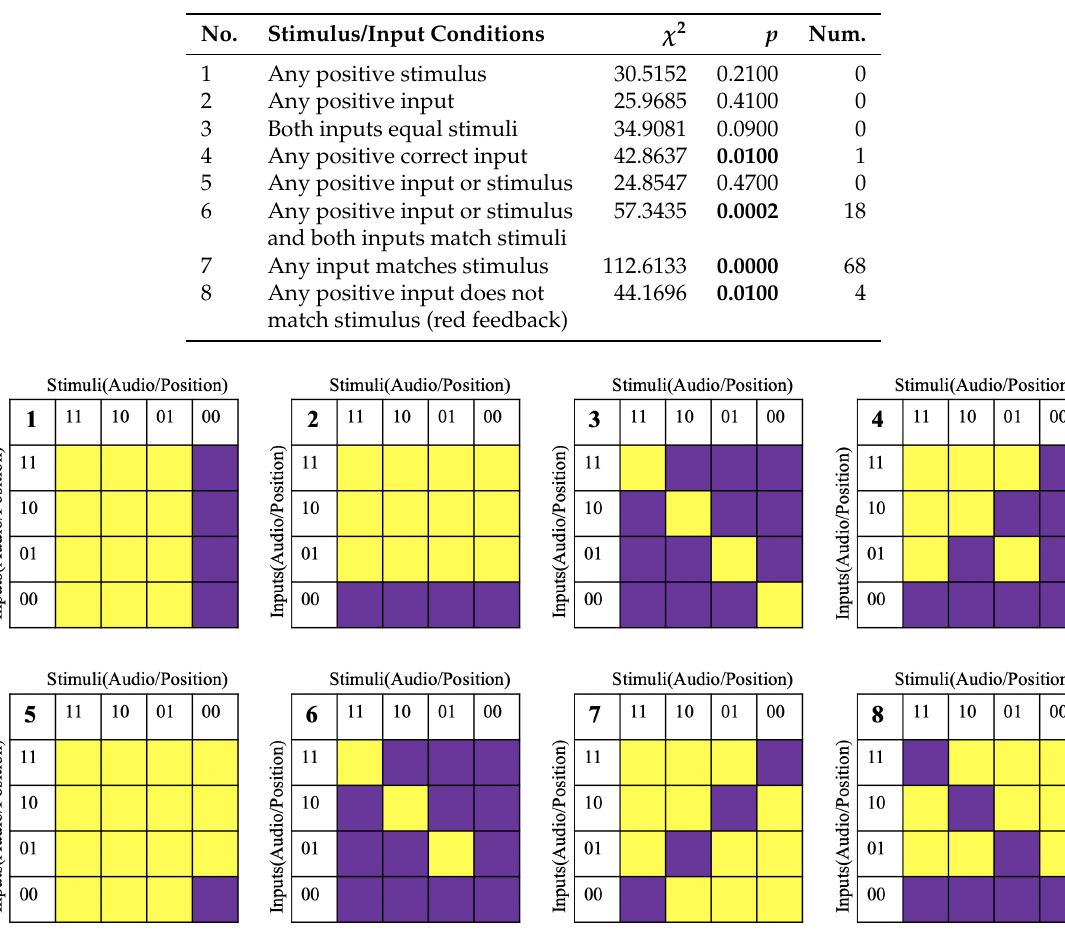
Figure 12. Truth table of the stimulus/input conditions. Golden cells are the conditions listed in Table 1, the Purple cells are the opposite